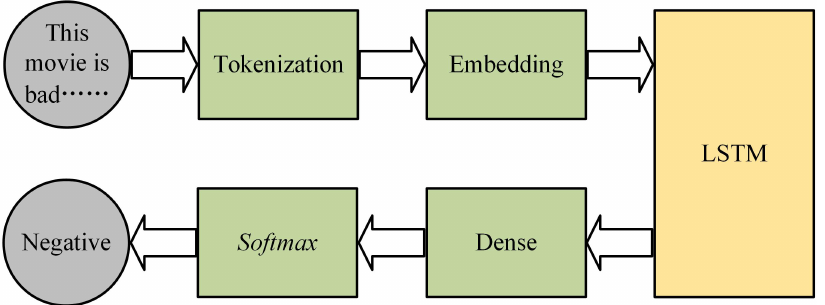
Figure 7. LSTM-based algorithm for sentiment analysis.